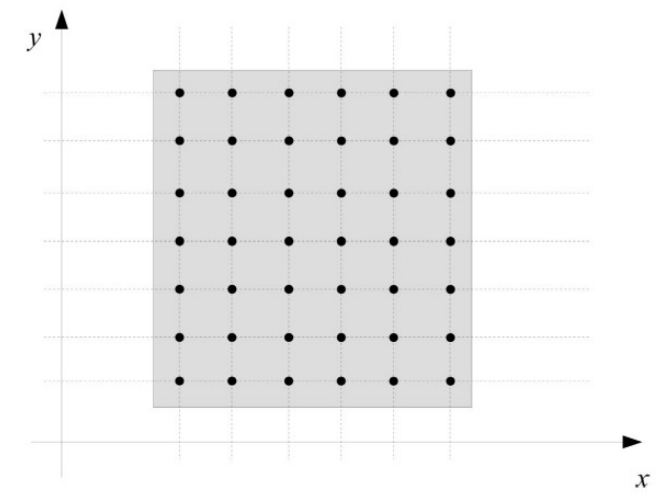
Figure 5. Uniform quadrature